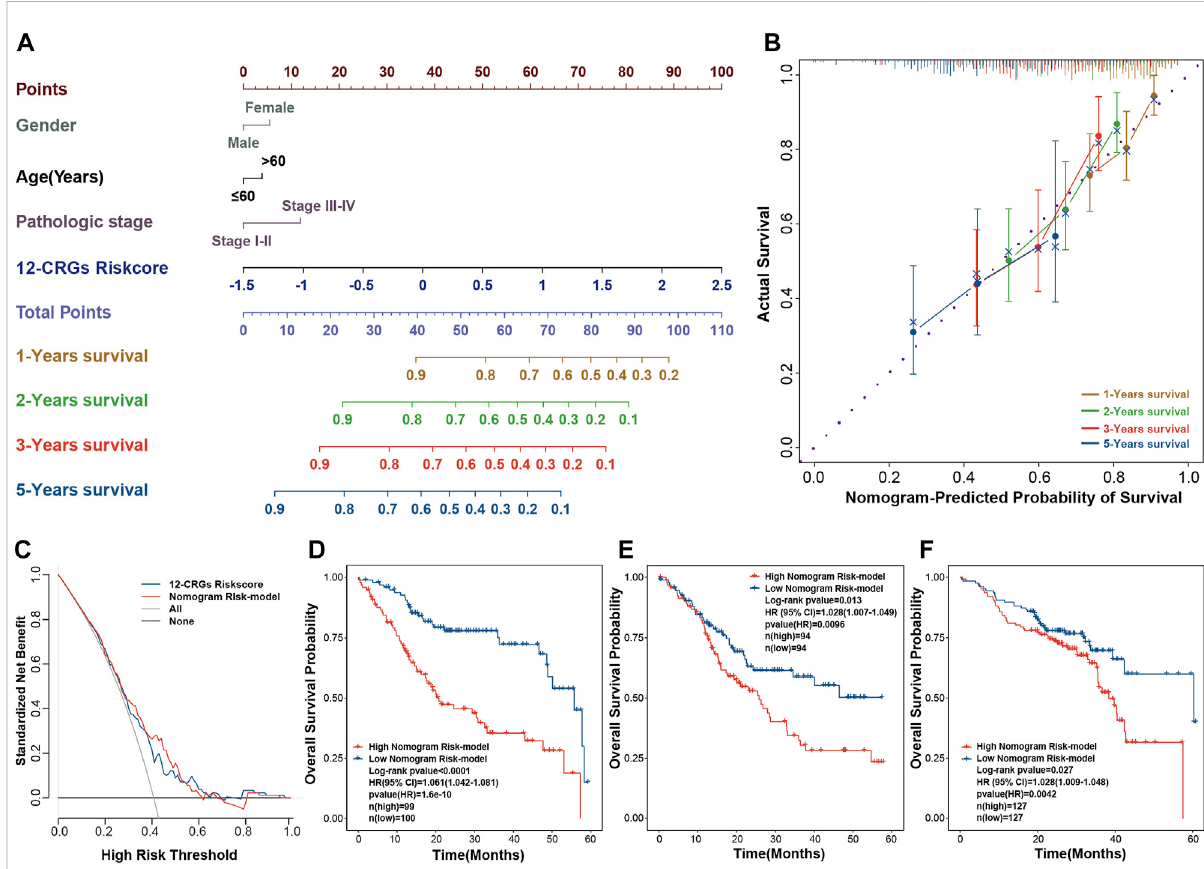
FIGURE 7 Construction of a nomogram for clinic utilization (A) A visual nomogram for predicting the OS at 1-, 2-, three- and 5-year after diagnosis (B) Calibration curve for assessing the predictive ability of the nomogram (C) Decision curve for evaluating the clinic use of the nomogram (D – F) Association of the nomogram scores with OS in TCGA- fi rst (D) , TCGA-second (E) and GSE65858 (F)